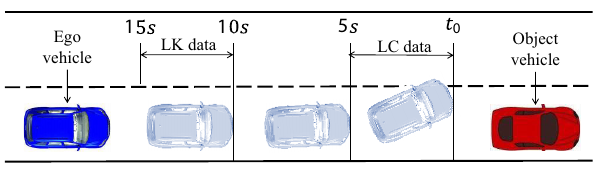
Figure 4 Data labeling for LC and LK